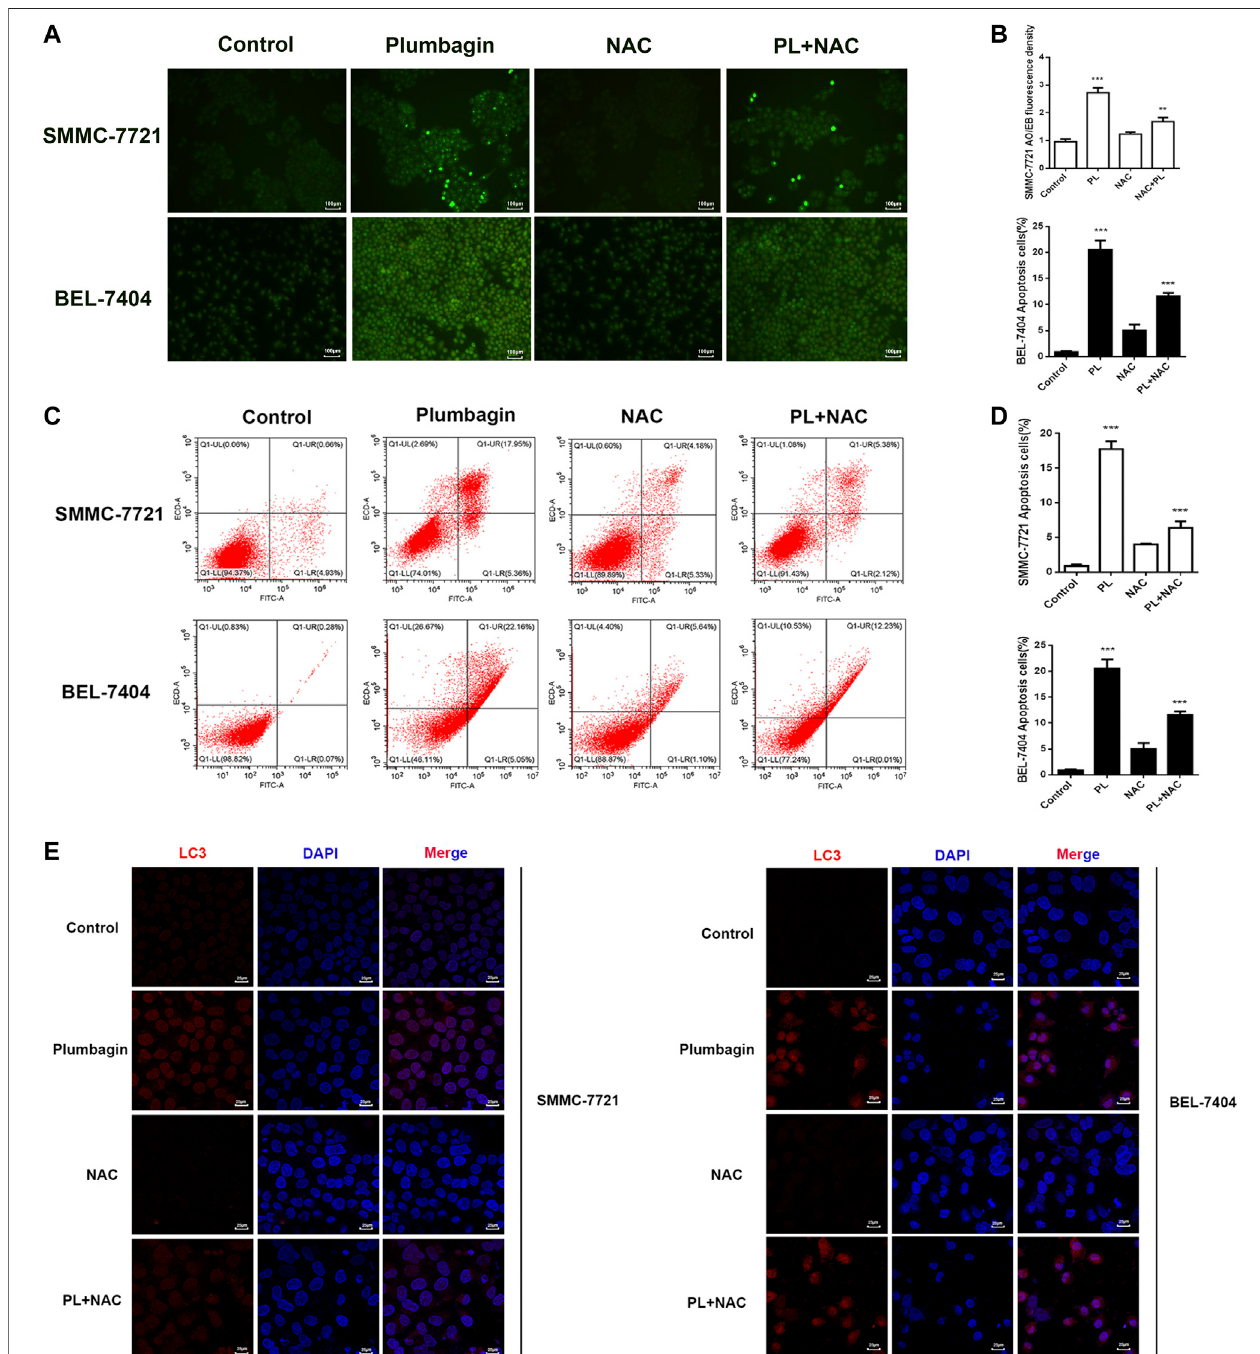
FIGURE 5 | (A) AO/EB staining to detect the formation of PL-induced BEL-7404 cells and SMMC-7721 apoptotic bodies. Scale bar, 100 μ m. All data are representative of at least three independent experiments. (B) Data were shown as the mean ± SD. * p < 0.05, ** p < 0.01 vs. the normal control group. (C) SMMC-7721 and BEL-7404 cells werepretreatedwith 10 mM NAC for30 minand werethen treated with5 μ M PL for24 h. Then, theratioofapoptosis wasmeasured and analyzed by Annexin V-FITC/PI staining and fl ow cytometry. (D) Data are shown as the mean ± SD. * p < 0.05, ** p < 0.01 vs. the normal control group. (E) SMMC-7721 and BEL-7404 cells were pretreated with 10 mM NAC for 30 min and were then treated with 5 μ M PL for 24 h. Immuno fl uorescence detection of LC3 expression. The expressionofLC3(red)wassigni fi cantlyhigher.ThemorphologyofSMMC-7721andBEL-7404cellshadafusiformshaperatherthanaroundedshape.Cellnucleiwere de fi ned by DAPI (blue). Scale bar, 25 μ